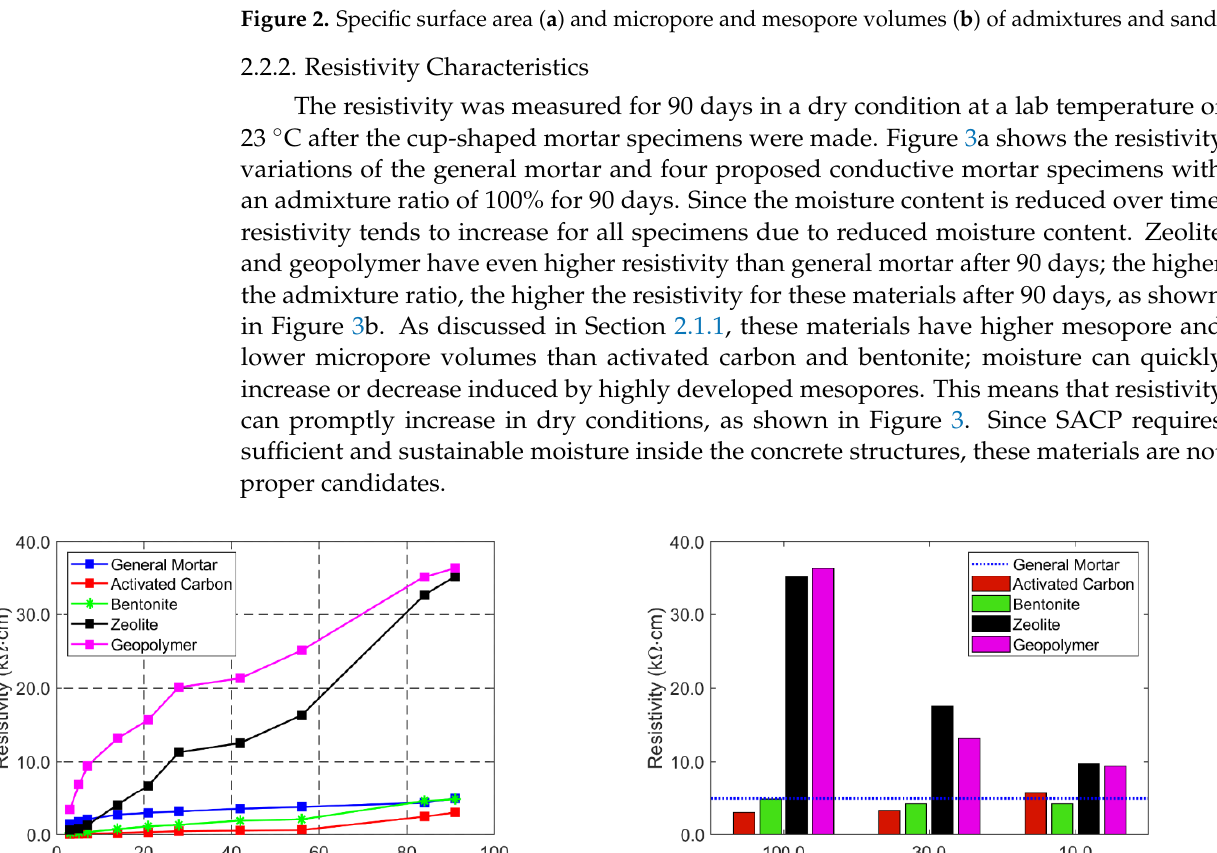
ratio of 100% for conductive mortars) ( a ) and resistivity after 90 days at different admixture ratios